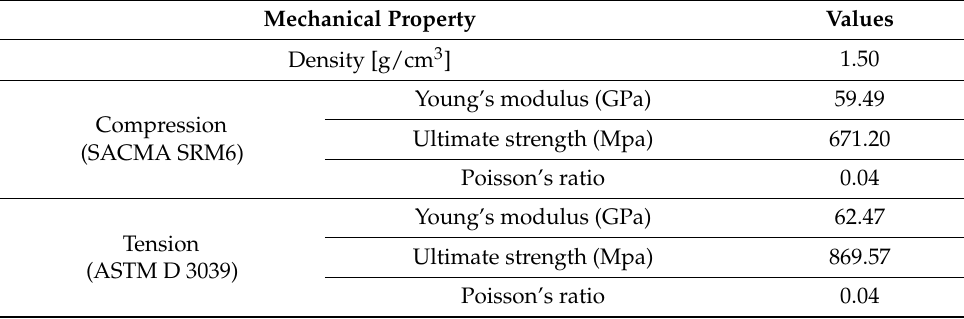
Table 1. Mechanical properties of CFRP laminate [0/90].